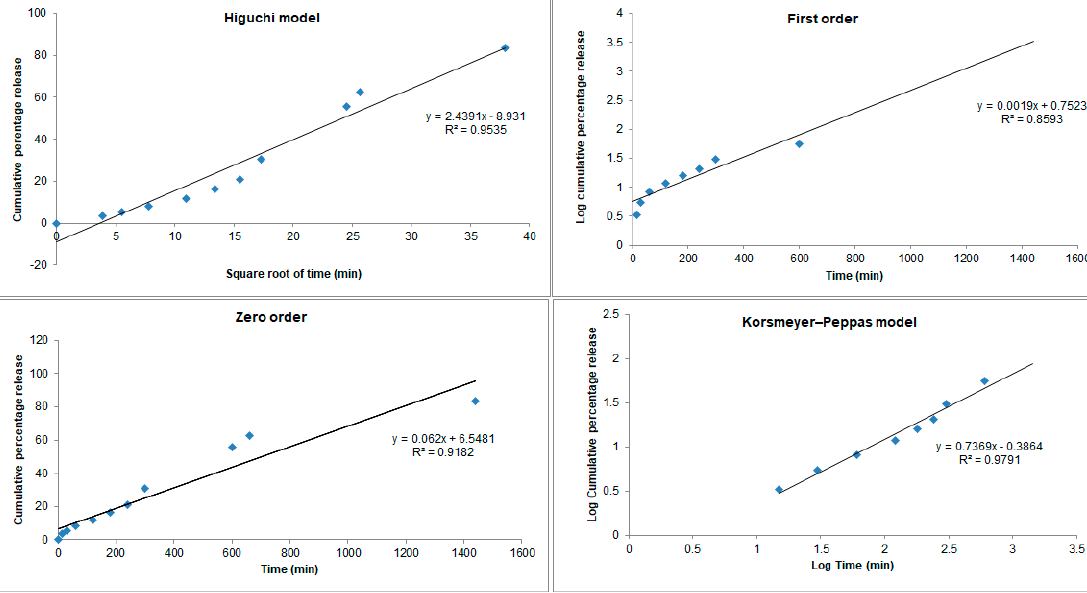
Figure 2. Mathematical fitting models of the release profile of perillaldehyde 1,2-epoxide from cPa -SLN over 24 h.